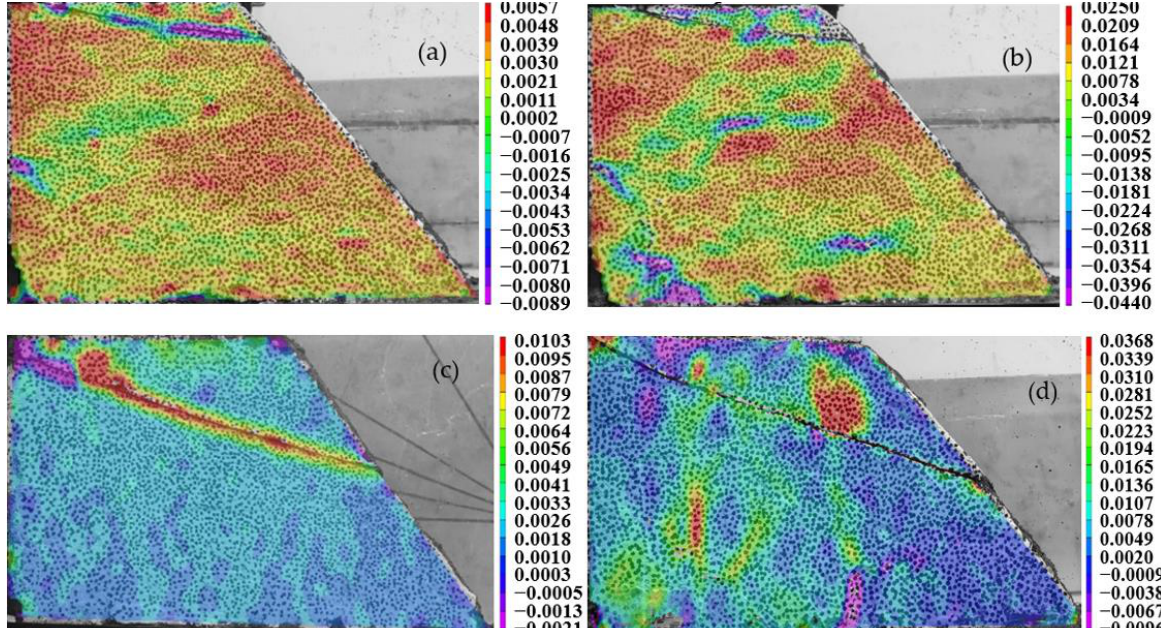
Figure 9. Strain contours of the slope model with one crack under different loadings and irrigation with a flow rate of 25 mL/min. ( a ) Under 1.6 MPa at 10°; ( b ) under 16 MPa at 10°; ( c ) under 1.6 MPa at 20°; ( d ) under 16 MPa at 20°.